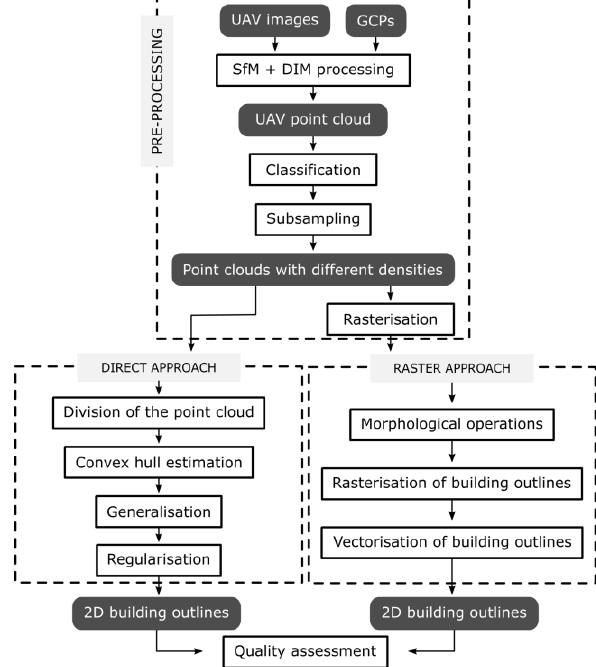
Figure 1. The processing workflow for building outline extraction based on UAV photogrammetric point cloud.